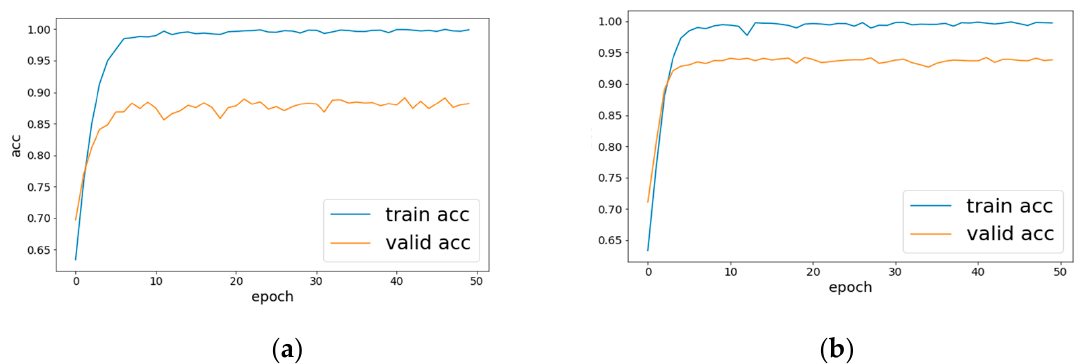
Figure 10. ( a ) represents the training and validation accuracy for the four classification tasks in Experiment 1, with the input data as EEG sequence information. ( b ) represents the training and validation accuracy for the four classification task in Experiment 2, with the input data as a 20 × 65 × 3 time-frequency plot.